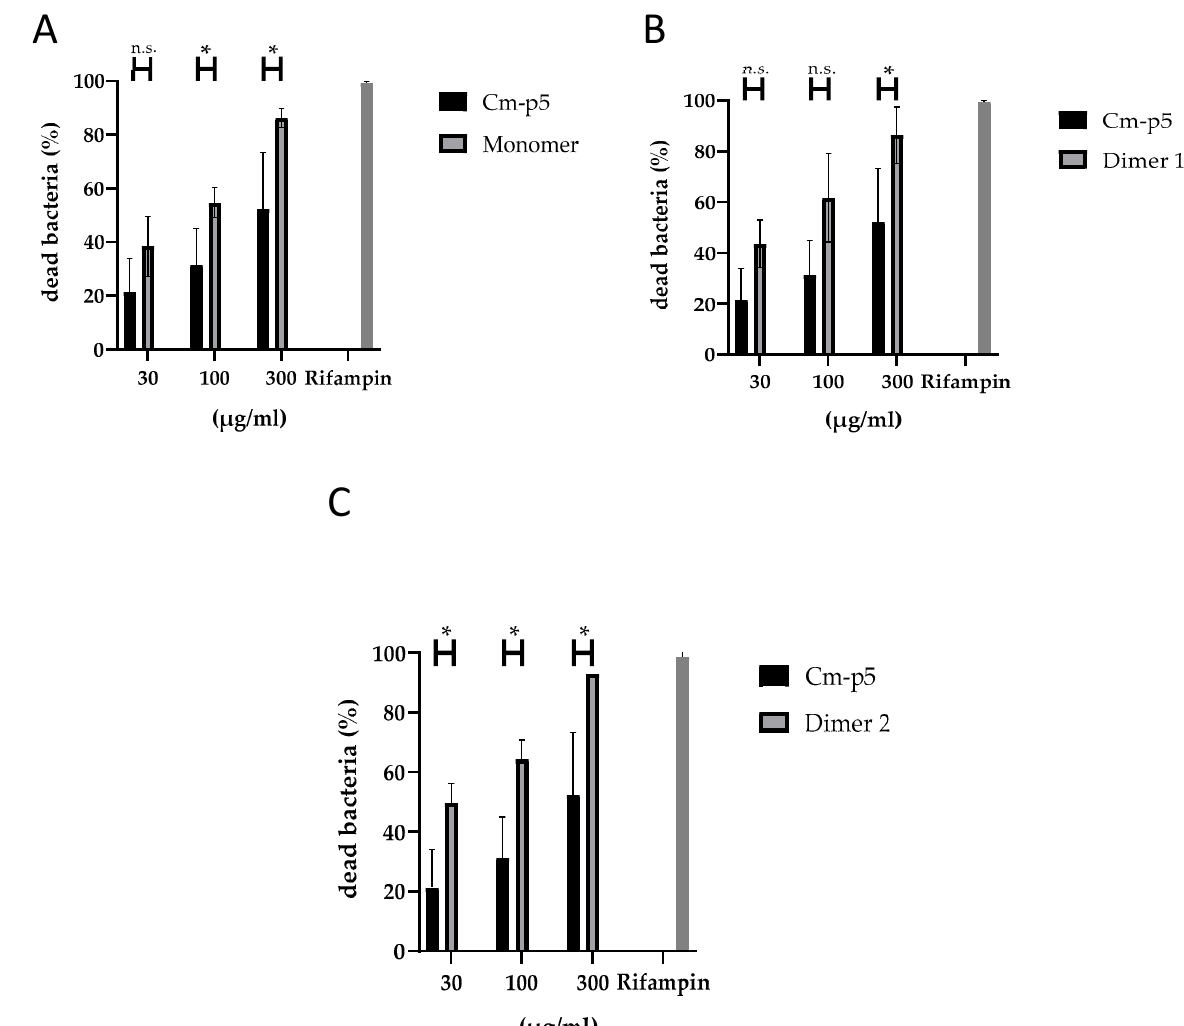
Figure 2. Antimycobacterial activity of Cm-p5 and its derivatives Monomer, cyclic ( A ), Dimer 1 ( B ) and Dimer 2 ( C ) at different concentrations (30 µg/mL, 100 µg/mL, 300 µg/mL) on virulent extracellular Mycobacterium tuberculosis was determined using 3 H-uracil proliferation assay. Bacteria were incubated in the presence of AMPs for 3 days and an additional day with 3 H-Uracil. Rifampin (2 µg/mL) was used as a positive control. Experiments were performed in triplicates and the results are shown as mean values of three independent experiments. Statistical significance was calculated using the Wilcoxon rank-sum test (n.s. = not significant, * = p ≤ 0.05).